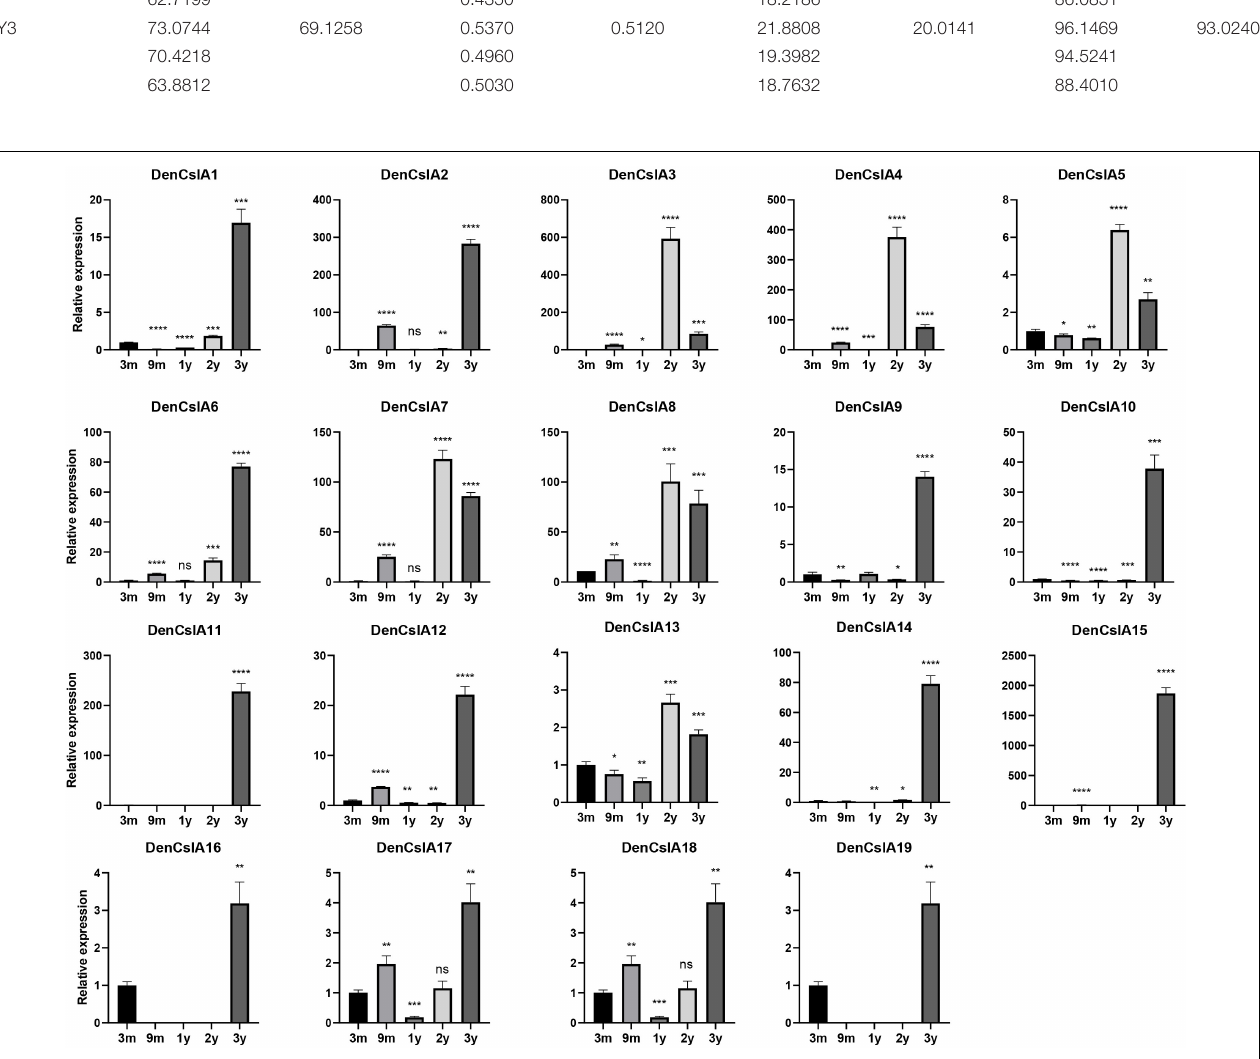
FIGURE 7 | Expression levels of DofCslA genes in the stems of D. officinale in different growth stages (including 3M, 9M, Y1, Y2, and Y3), as determined by qRT–PCR analysis. The results are shown as the means ± SDs of three independent experiments. The presented expression levels are relative to the expression of the reference gene. * p value < 0.05, ** p value < 0.01, *** p value < 0.001, **** p value < 0.0001.